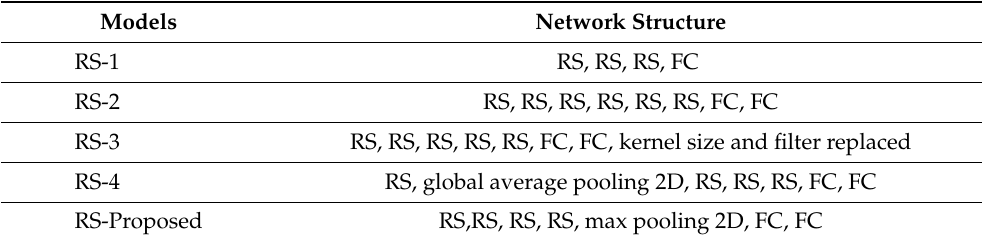
Table 3. Network structures of several models included in ablation